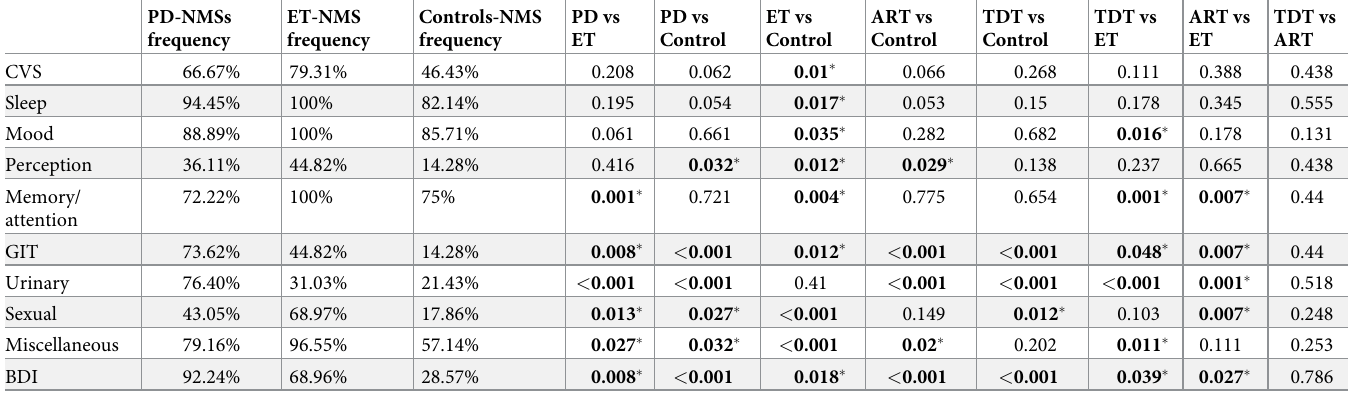
Table 3. Comparison of frequency of NMSs between different